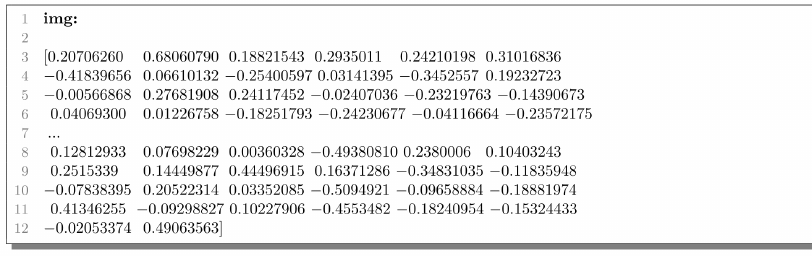
Figure 3. The word vector of “img” training by